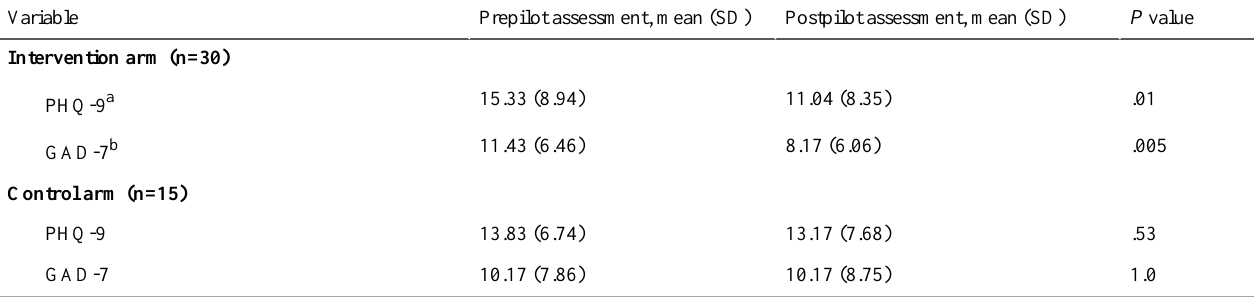
Table 4. Pre-post change in depression and anxiety symptoms: intervention (n=30) vs control (n=15).